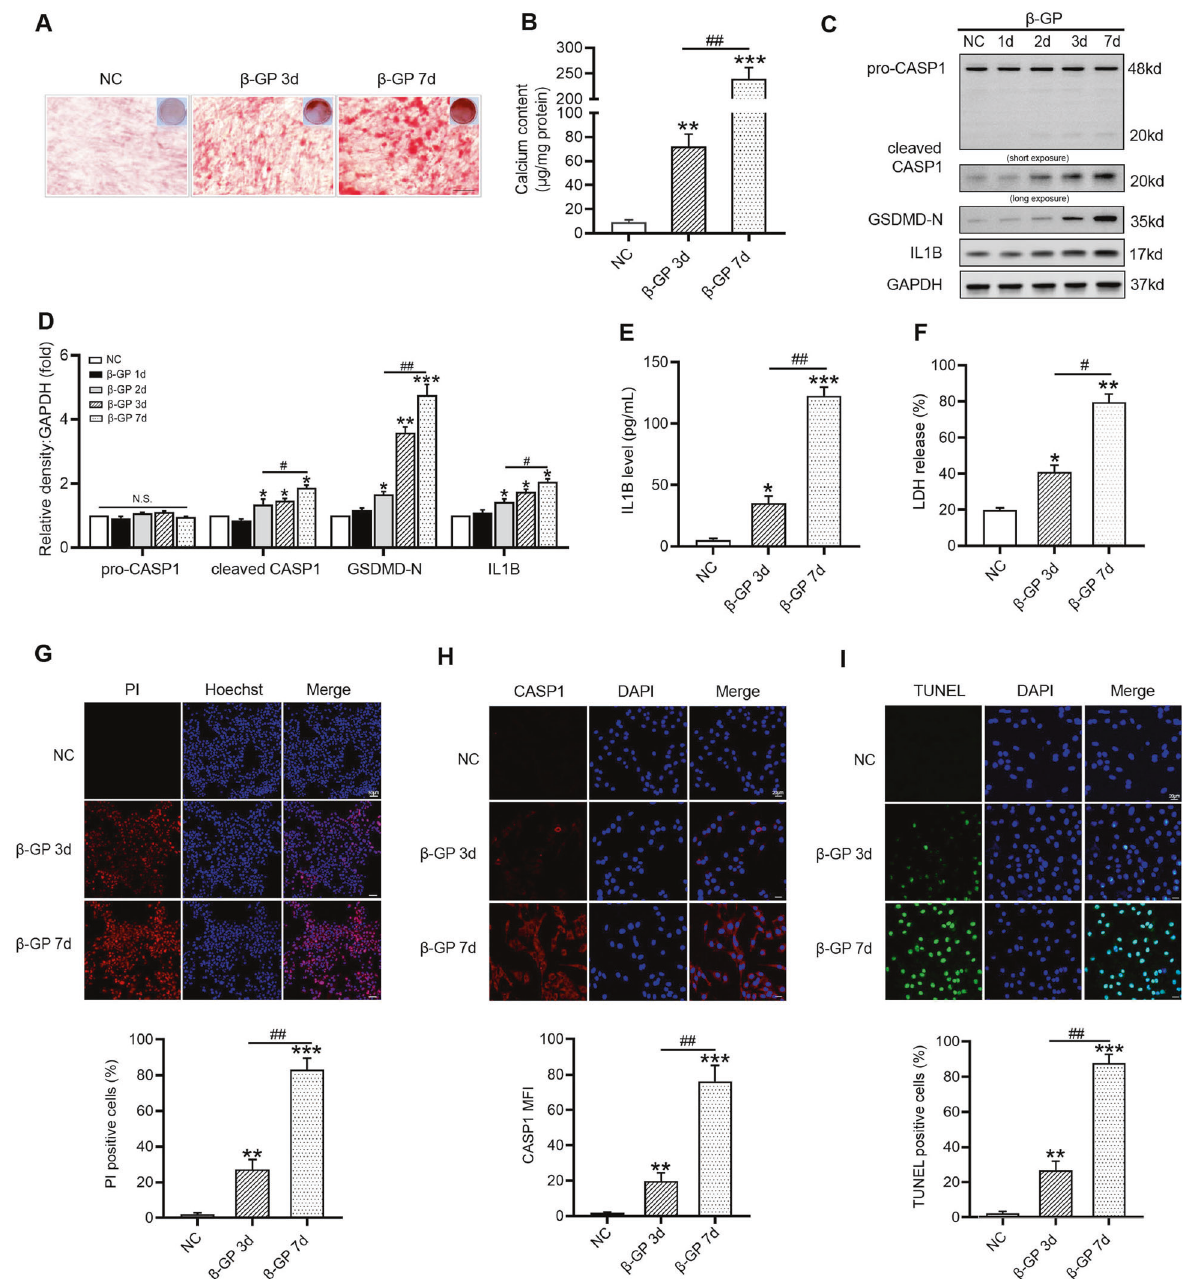
Fig. 1 Pyroptosis occurs in VSMCs after exposure to β -GP. VSMCs were treated with β -GP (10 mM) for the indicated time. A Calcium deposition in VSMCs was assessed by Alizarin red staining (positive staining: red; scale bar = 100 μ m). B Quantitative analysis of calcium deposition in VSMCs normalized to the protein content. C Protein levels of pro-CASP1, cleaved CASP1, GSDMD-N, and IL1B were determined by western blotting. D Quanti fi cation of the results shown in C. E The IL1B content in VSMC culture supernatants was determined by ELISA. F The release of LDH was detected using the LDH Assay Kit. G The percentage of PI-positive cells was measured using Hoechst 33342 (blue)/PI (red) double staining (top: Representative images; bottom: Quantitative analysis of PI-positive cells). H CASP1 expression was determined by immuno fl uorescent staining (top: Representative images; bottom: Mean fl uorescence intensity (MFI) of CASP1 was quanti fi ed). I The percentage of TUNEL-positive cells (green) was evaluated by TUNEL staining (top: Representative images; bottom: Quantitative analysis of TUNEL-positive cells). Scale bar = 50 μ m for ( G ); Scale bar = 20 μ m for ( H ) and ( I ). Data are expressed as mean ± SEM. *P < 0.05, **P < 0.01, ***P < 0.001 vs. control group; # P < 0.05, ## P < 0.01 vs. indicated group; and N.S. not signi fi cant.